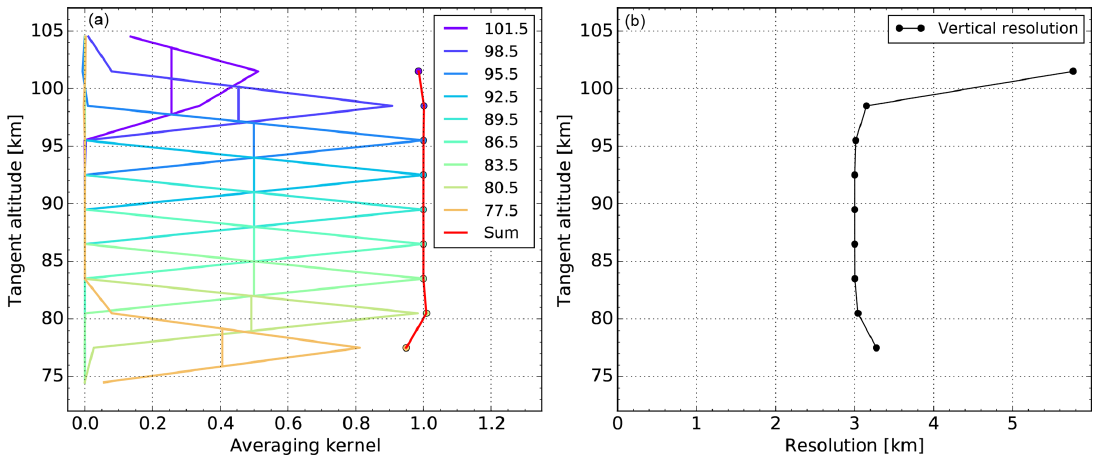
Figure 7. (a) The averaging kernel and (b) the vertical resolution of the retrieval for February 2006 at 10–20 ◦ N and a local time of 22:00– 00:00LT. The vertical resolution is obtained from the distribution of each row in the averaging kernel by calculating the corresponding